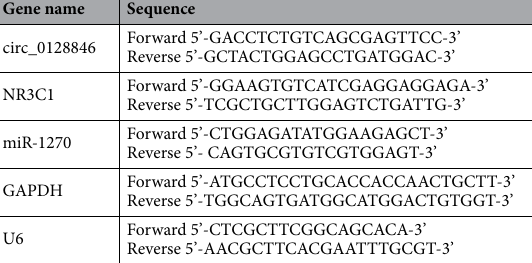
Table 2. Real-time PCR primer